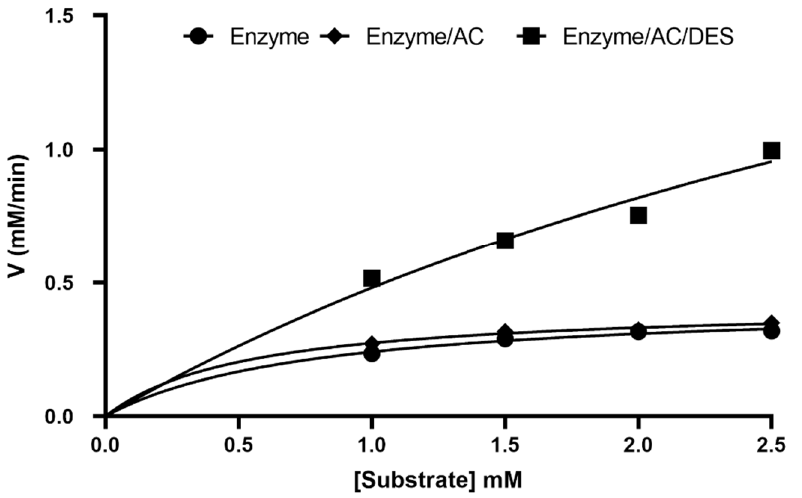
Figure 8. Non-linear kinetic curve (Michaelis–Menten equation) for PPL: free enzyme (control), enzyme with AC, and enzyme with AC/DES, generated by GraphPad Prism version 9.0.0.